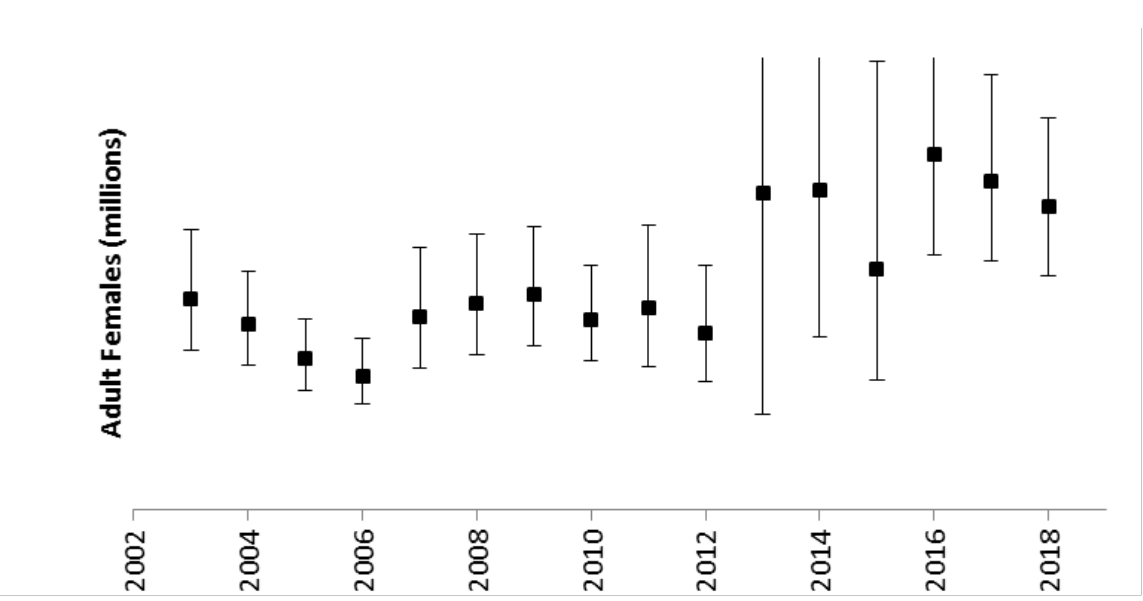
Figure 5. CMSA model estimated adult (primiparous + multiparous) female abundance with lower and upper 95% confidence limits. Upper confidence limits for 2013, 2014, and 2016 extend beyond the y-axis with values of CONFIDENTIAL. Y-axis values have been removed due to CONFIDENTIAL